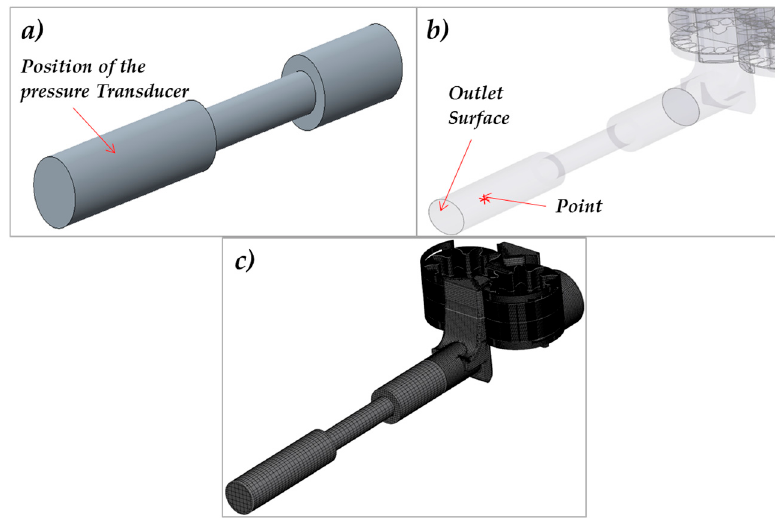
Figure 17. ( a ) Calibrated orifice geometry, ( b ) pressure ripples monitoring point, ( c ) mesh of the entire model.